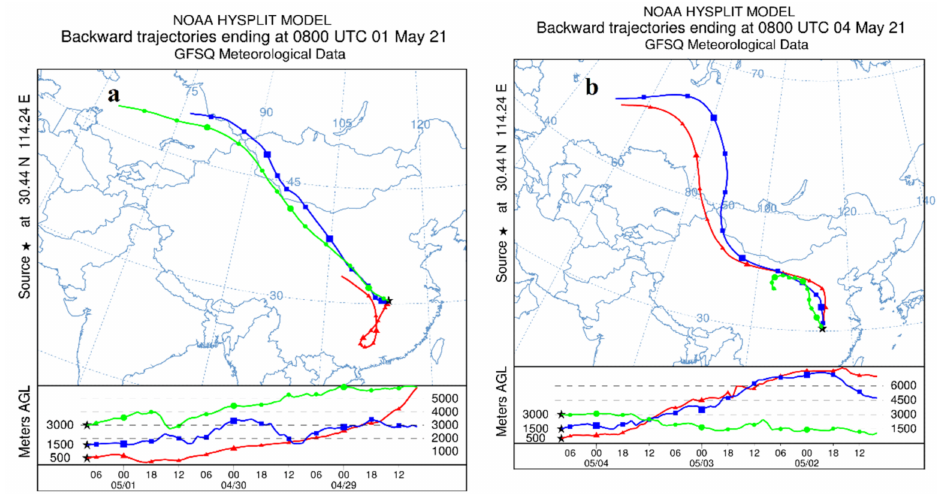
Figure 9. The 72-h backward trajectory tracking analysis results for Wuhan using the HYSPLIT model (web-version) on ( a ) 1 May, and ( b ) 4 May 2021. The red, blue, and green lines represent the trajectories of different high airflow sources (500, 1500, 3000) in the study